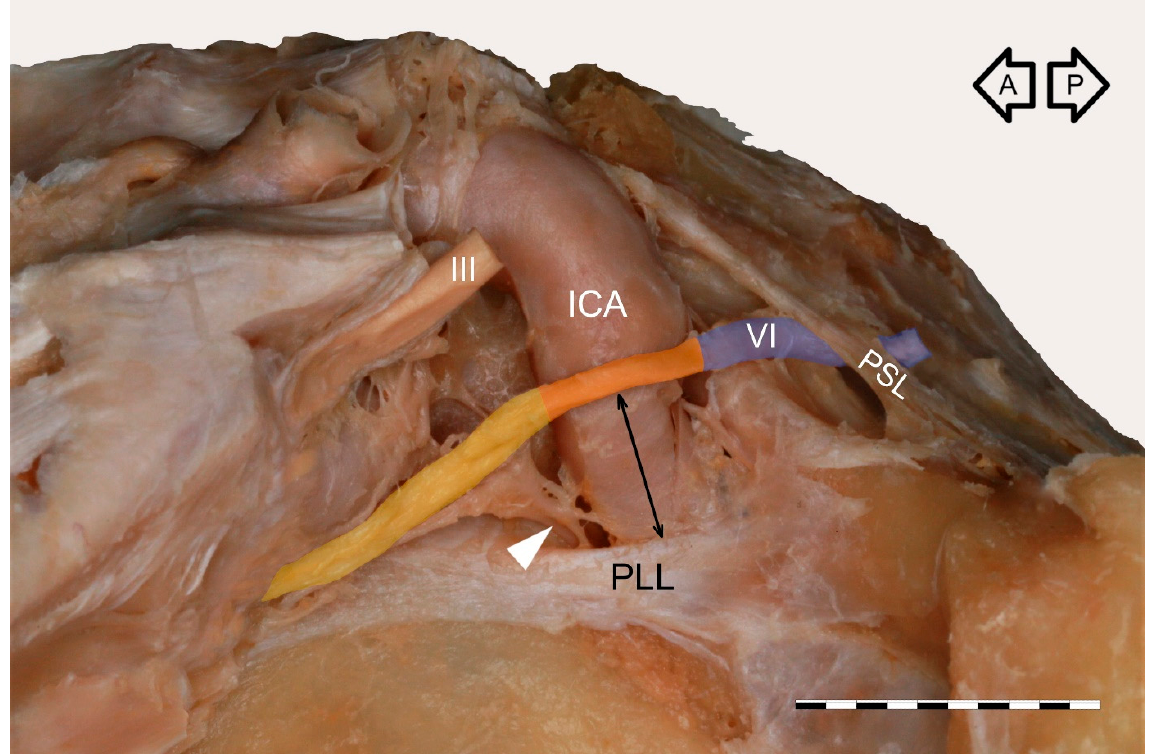
Figure 9. Proposal for subdivision of AN cavernous segment into the carotid portion (marked by orange) located at the point of contact with the cavernous part of the ICA and prefissural portion (pale yellow) located between the anterior aspect of the vertical part of the cavernous part of the ICA and the superior orbital fissure. Wet specimen of the left CS. The distance between the carotid portion of the AN and the petrolingual ligament (PLL) is marked by a double arrow line. The gulfar segment of the AN is colored blue. The white arrowhead marks an anterior bundle of the sympathetic nerve fibers joining the AN’s inferior aspect. III—oculomotor nerve; PSL—petrosphenoidal ligament. The black arrows indicate the anterior (A) and posterior (P) directions. Scale bar corresponds to 10 mm.